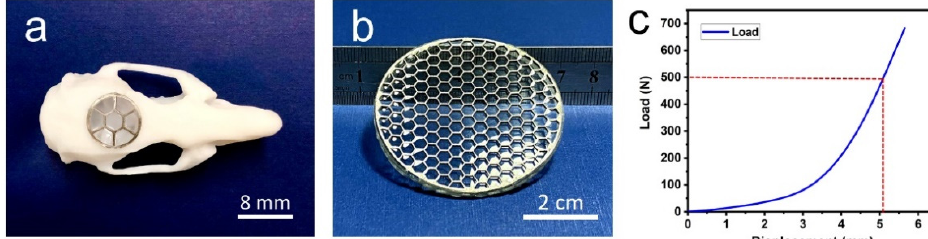
Figure 2. ( a ) A resin rat skull sample made by 3D printing technique with resin. In the middle of the top surface, a curved, 3D-ptinted circular Ti cranial window was fitted. Adapted with permission from Ref. [63]. 2022, Nana Yang et al. ( b ) Optical photograph of a 50 mm diameter, net-like Ti-PDMS cranial window. The circular Ti frame with thin hexagonal grids was firstly 3D-printed, polished, and then covered with a PDMS layer. ( c ) Raw data of mechanical test for one 50 mm diameter Ti-PDMS cranial window. It needed a static force of 500 N perpendicular to the Ti-frame at the center to let the central region show a 5 mm